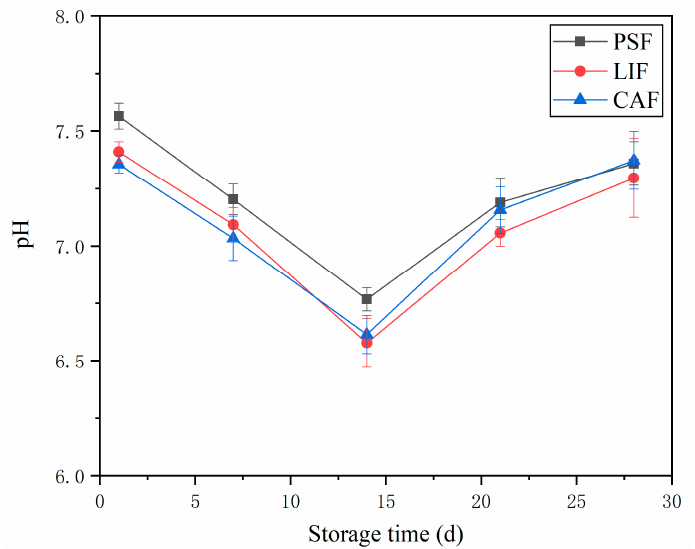
Figure 2. Changes in the pH of largemouth bass during frozen storage with different freezing meth- ods. Acronyms: PSF = Pressure − shift freezing; LIF = Liquid immersion freezing; CAF = Conventional air